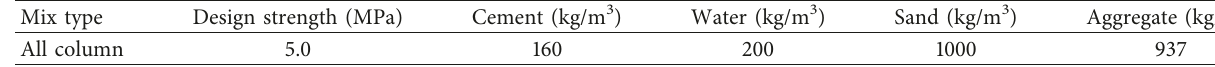
Table 1: Summaries of mix properties for concrete.